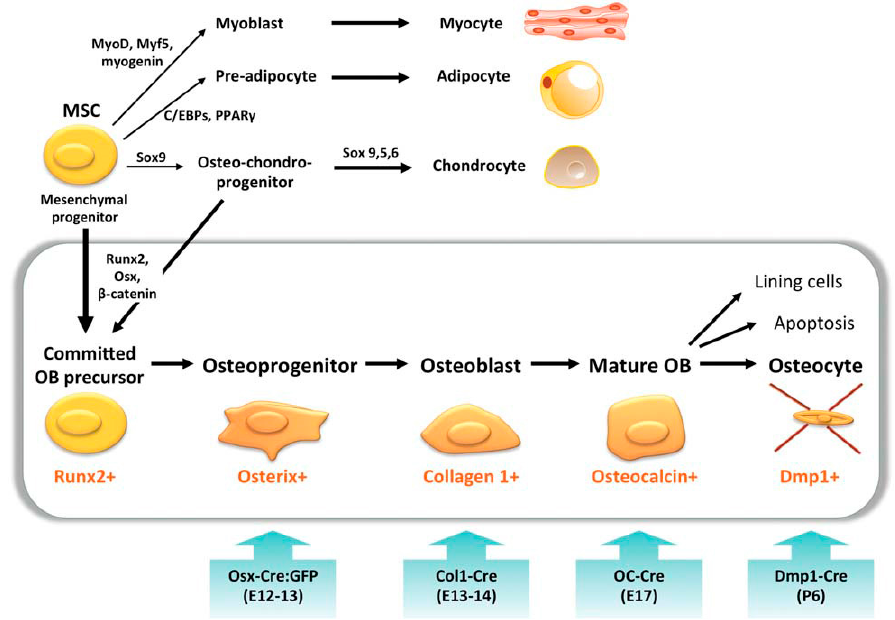
Figure 2. Schematic representation of the different steps of osteoblast (OB) differentiation from mesenchymal stem cells (MSC). With permission from Reference [35] .